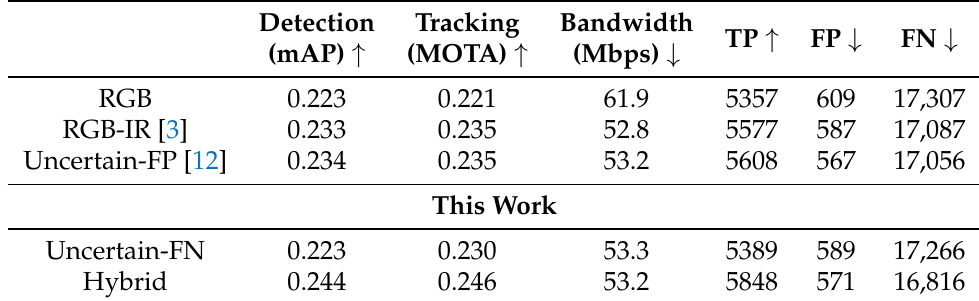
Table 1. Accuracy metrics on the CAMEL